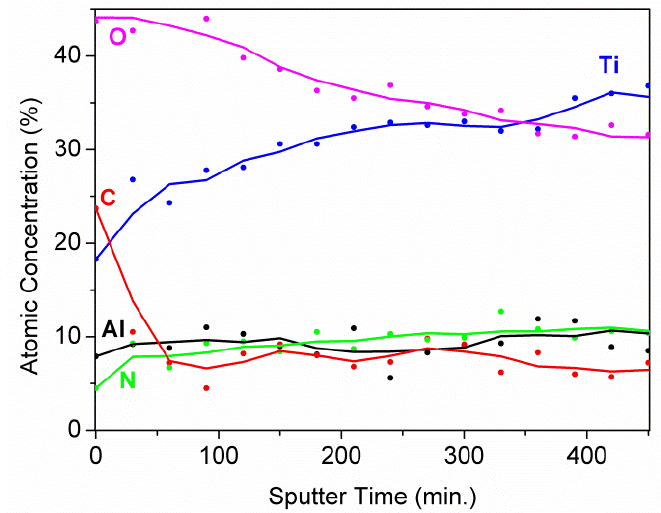
Figure 8. XPS depth profile of the Ti / TiN composite coating. The average sputtering rate was equal to 0.3 nm · min − 1 [19].